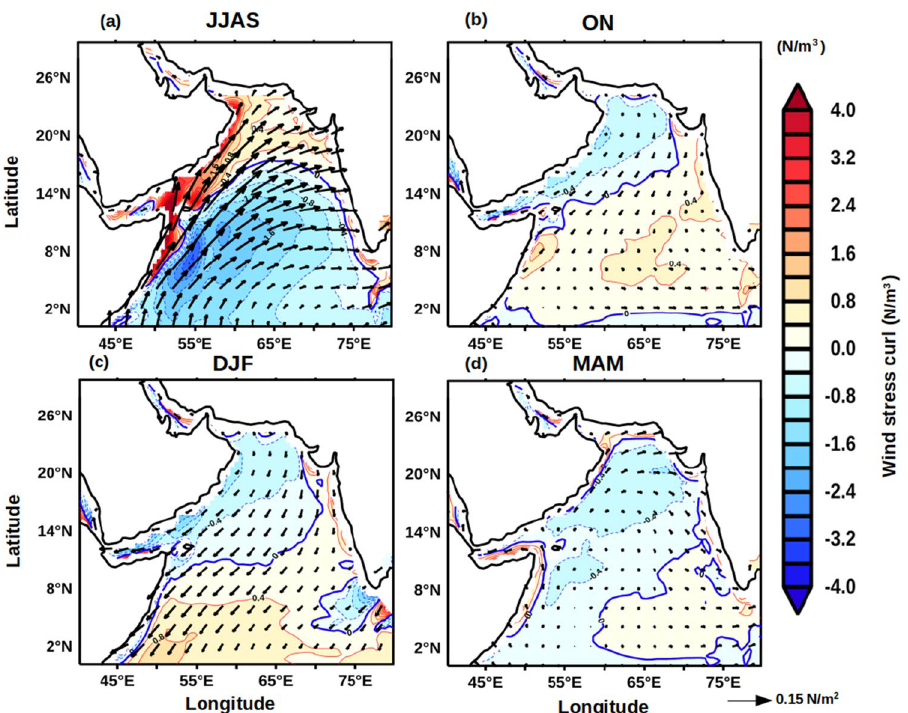
Figure 3. Annual cycle of climatology of wind stress curl (WSC, N/m 3 ) during ( a ) JJAS, ( b ) ON, ( c ) DJF, and ( d ) MAM. Contour lines represent the magnitude of zero wind stress curl while the arrows represent the wind stress (N/m 2 )